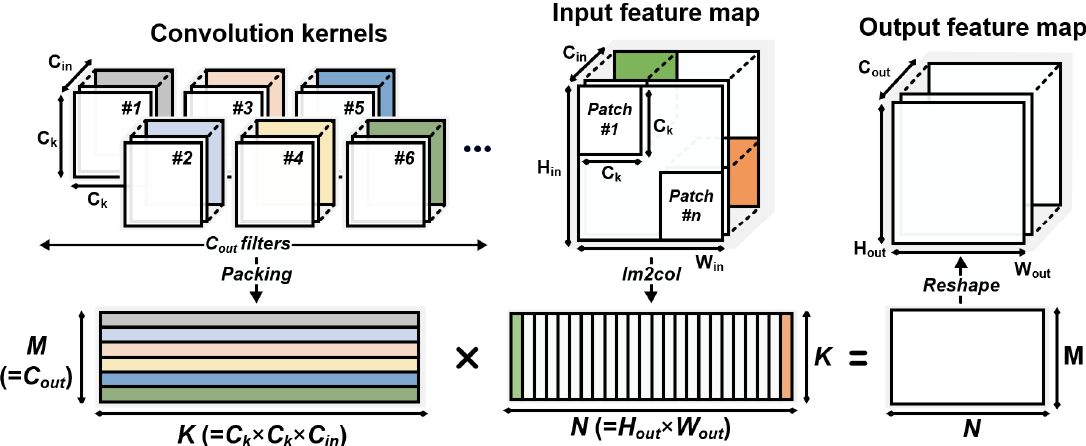
Figure 2. Matrix to matrix multiplication of matrices A (M×K) and B (K×N).